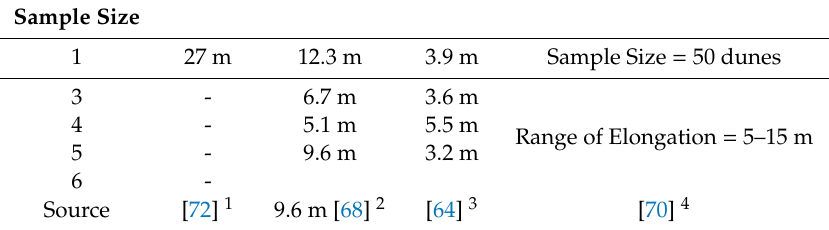
Table 3. Annual elongation rate of linear dunes in North Sinai Sand Sea.